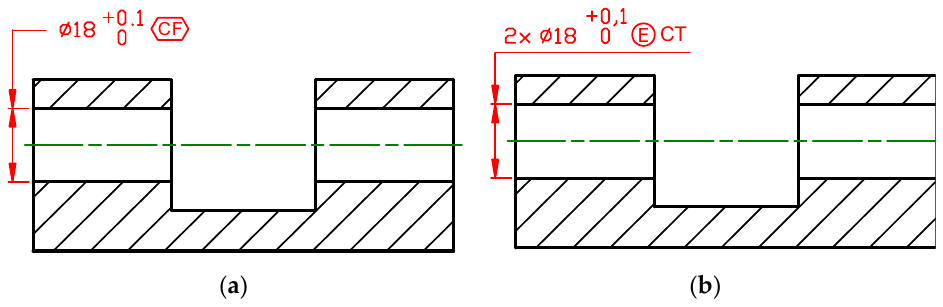
Figure 3. ( a ) Two coaxial holes shall be considered as one feature of size (ASME Y14.5); ( b ) common tolerance with the envelope requirement is applied to two separate single features of size to consider them as one feature of size (ISO GPS). To accept a part in both tolerancing systems, one cylinder with a diameter not less than 18 mm shall be inscribed into two holes simultaneously.